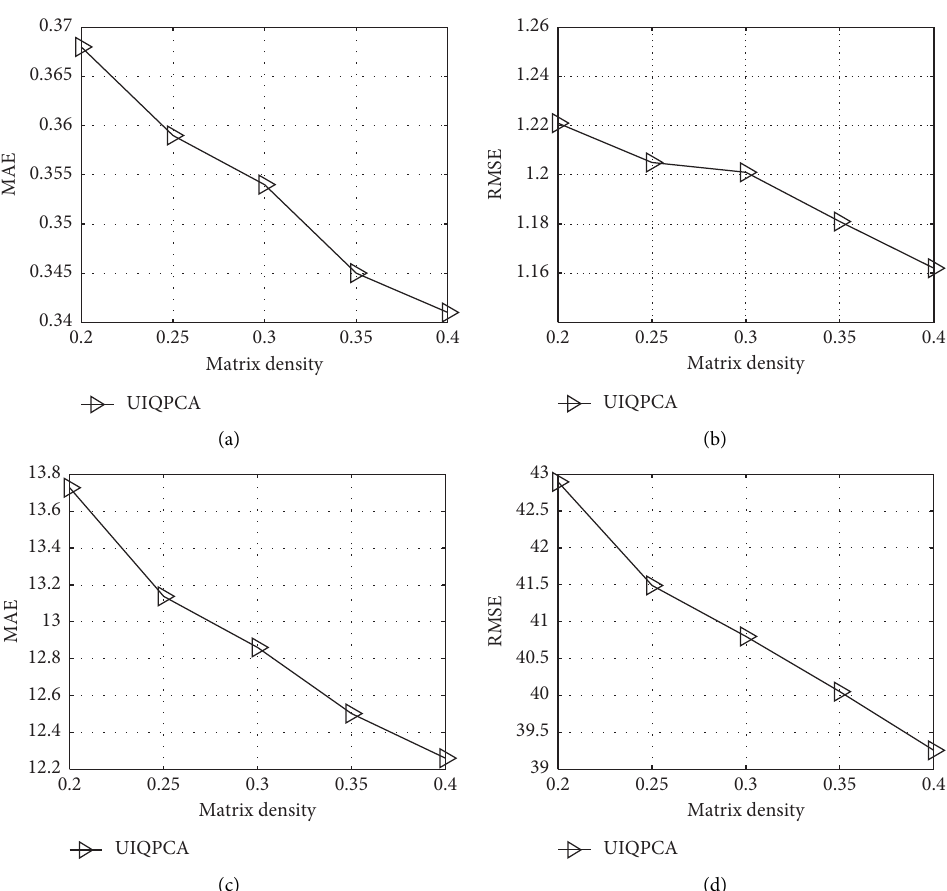
Figure 7: Impact of matrix density on UIQPCA with the WS-Dream dataset: (a, b) response time; (c, d) throughput. (a) MAE vs. matrix density. (b) RMSE vs. matrix density. (c) MAE vs. matrix density. (d) RMSE vs. matrix density.